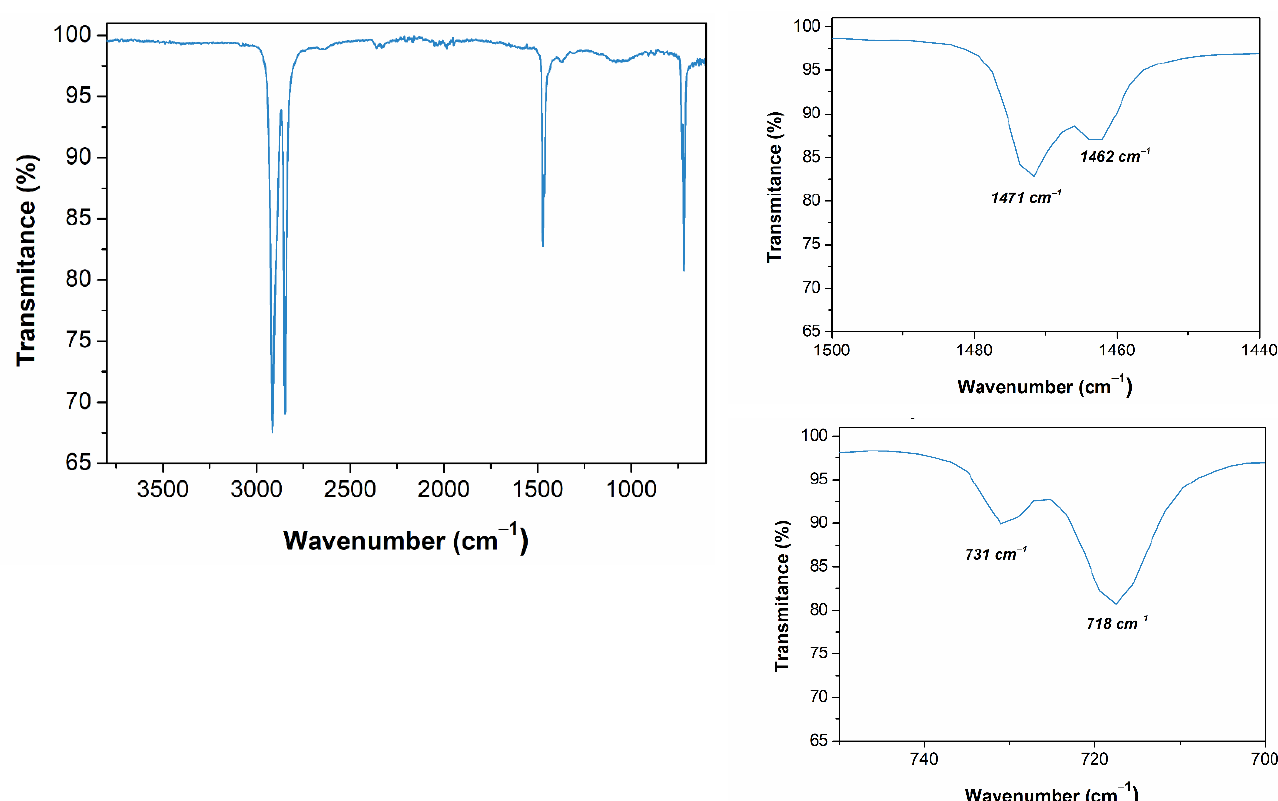
Figure 3. FTIR Spectrum of the recycled fishing net (rFN). Figure 3 . FTIR Spectrum of the recycled fishing net (rFN).